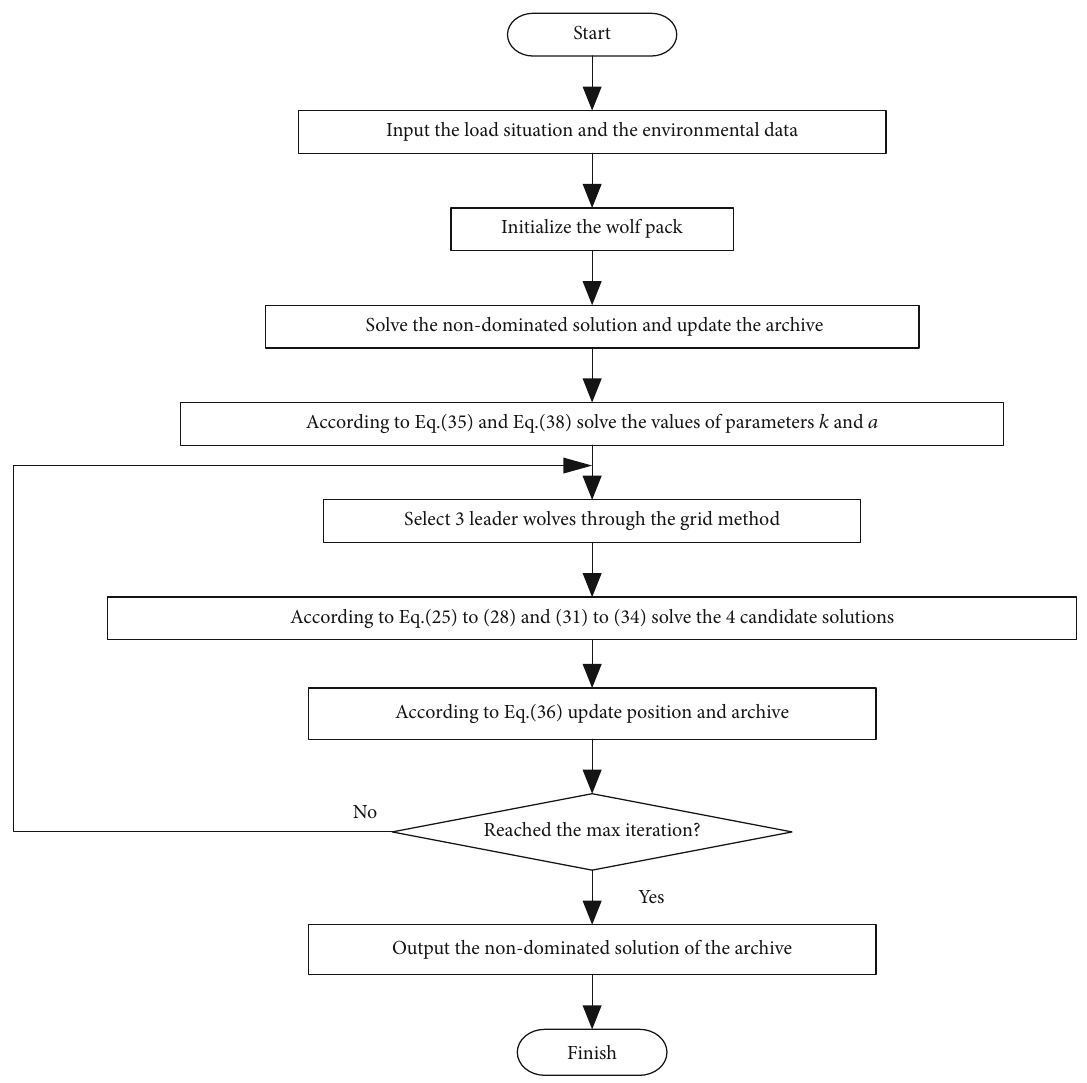
Figure 5: Algorithm optimization fl ow